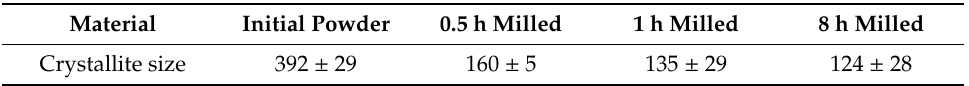
Table 2. Crystallite size of Fe28Al powder in the initial state and after milling for 0.5, 1, and 8 h measured by the Scherrer calculator from XRD patterns, given in nm.